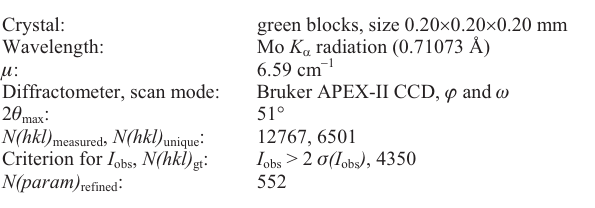
Table 1. Data collection and handling.